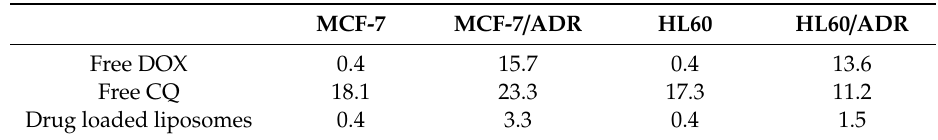
Table 2. IC 50 ( µ g / mL) values for free DOX, free CQ and drug-loaded liposomes on the di ff erent cell